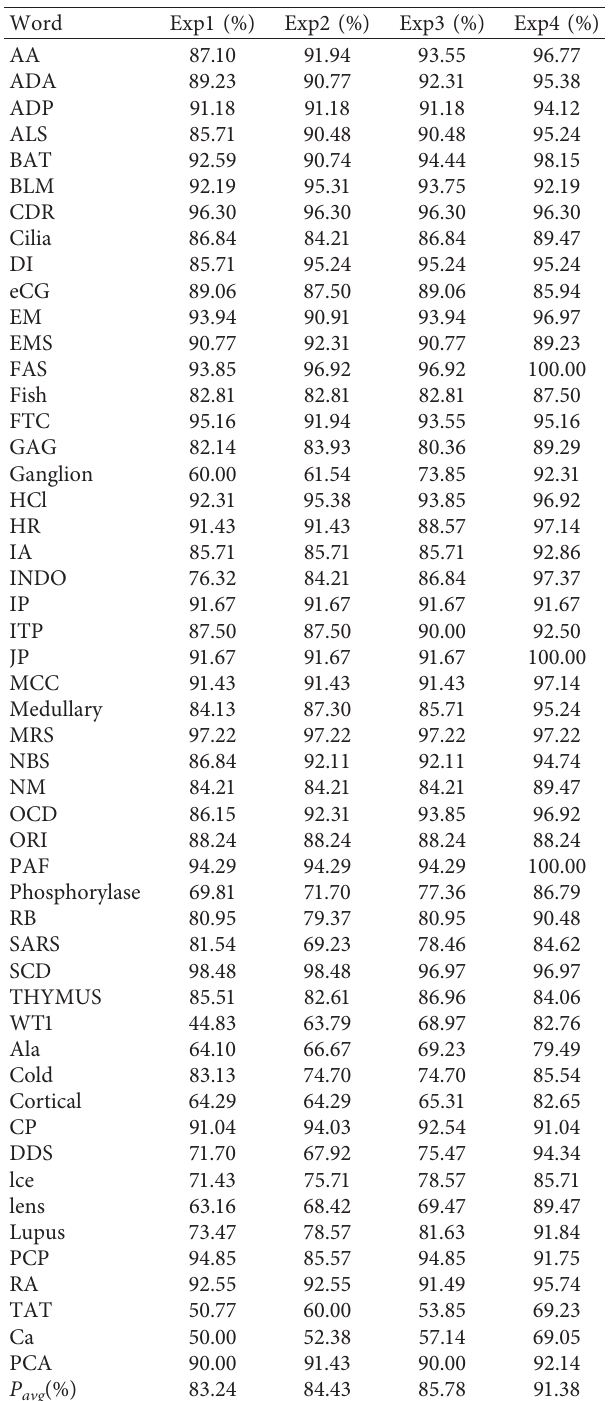
Table 1: Disambiguation accuracies from Experiment 1 to Experiment